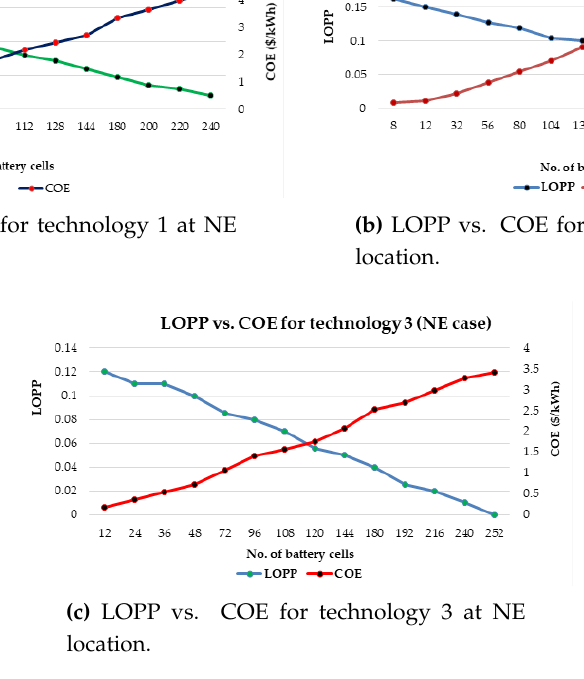
Figure 12. Technology selection for NE